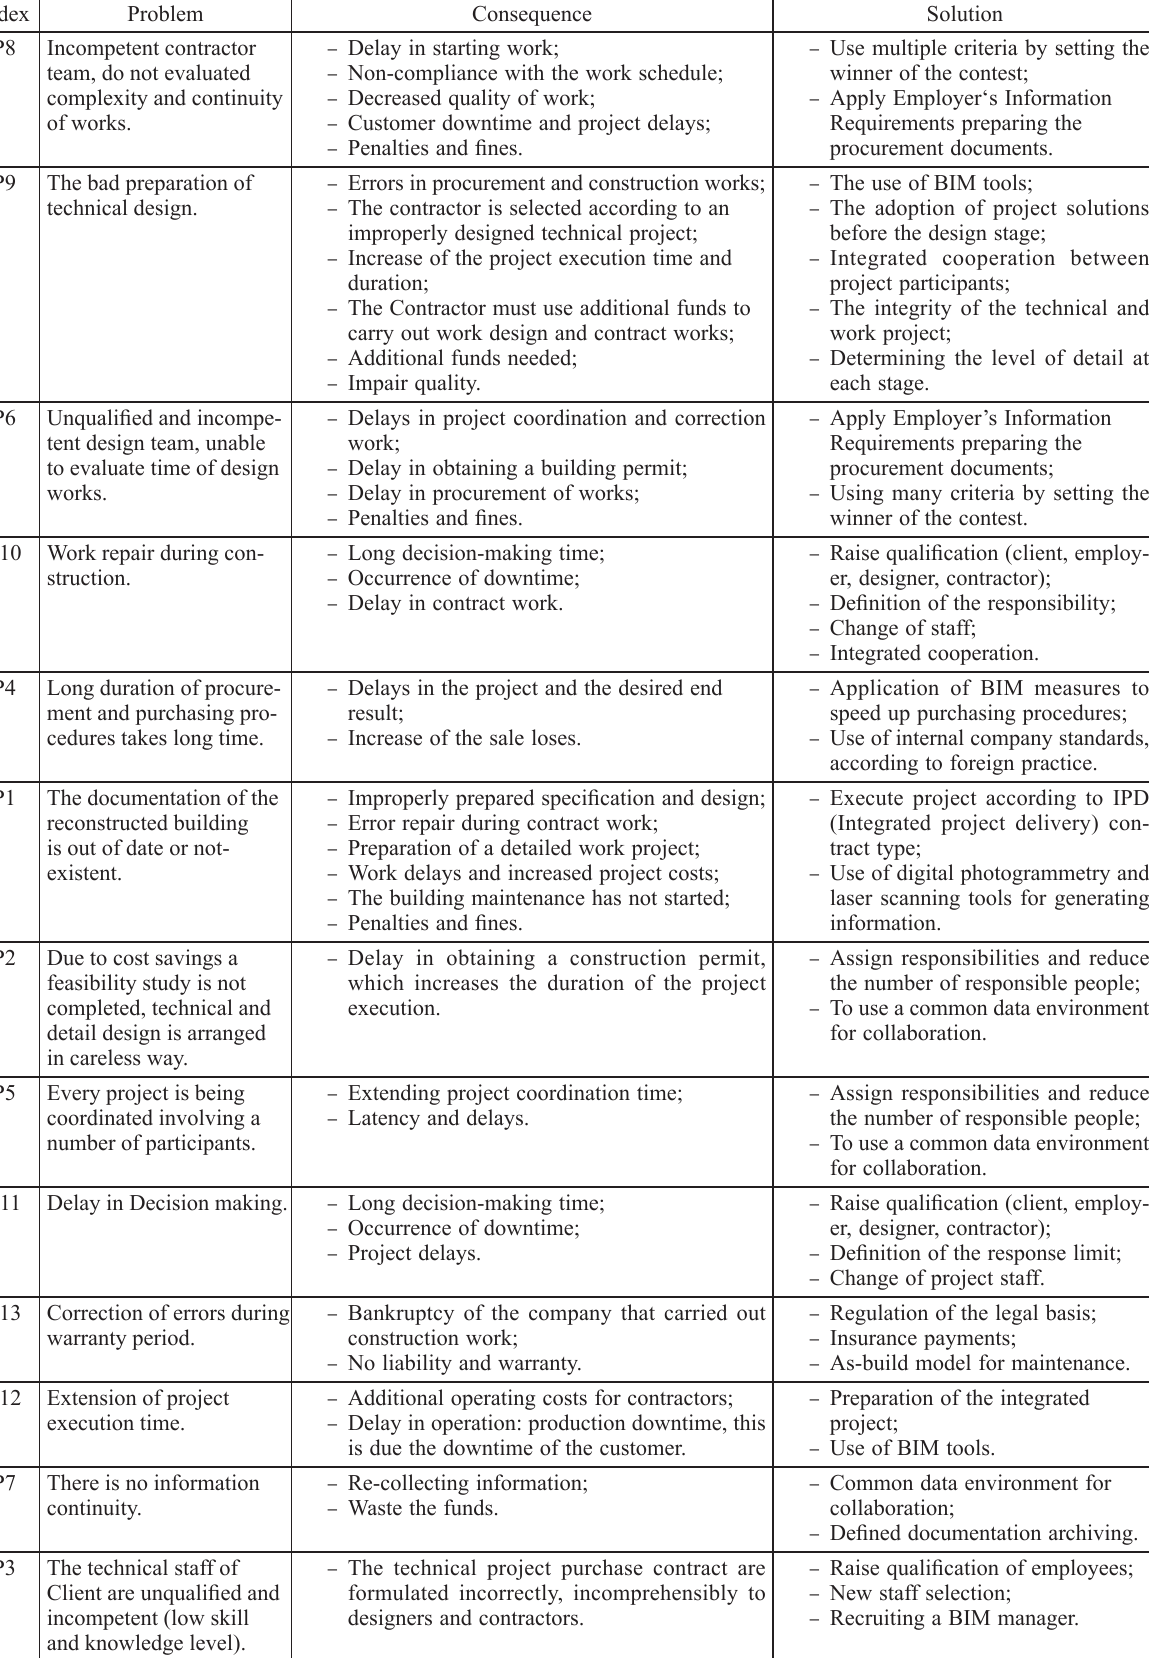
Table 5. Prioritised problems, consequences and